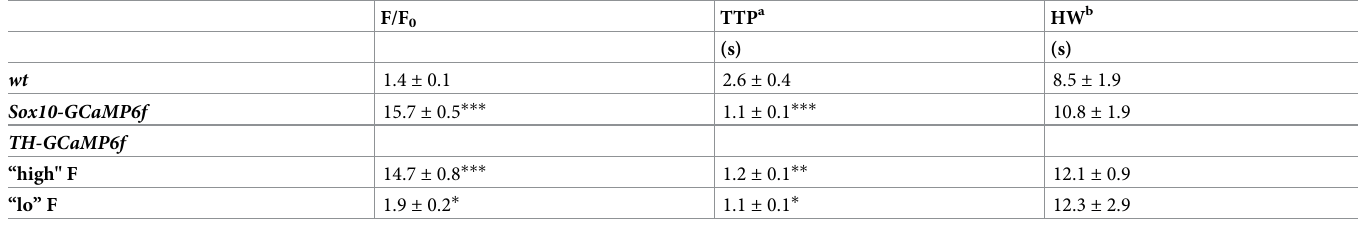
Table 2. Comparison of DMPP-evoked Ca 2+ responses in ACC derived from wt , Sox10-GCaMP6f and TH-GCaMP6f